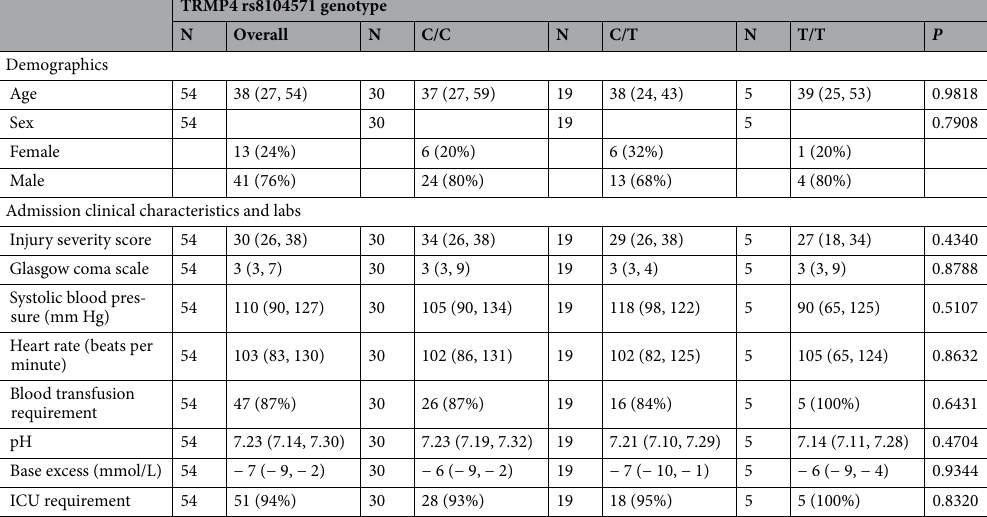
Table 7. Demographics, clinical characteristics, and TRMP4 rs8104571 genotype distribution for African Americans within the study population denoted as median (IQR) or number of observations (%). C cytosine, T thymine, ICU intensive care unit, IQR interquartile range, *Significant P values < 0.05.